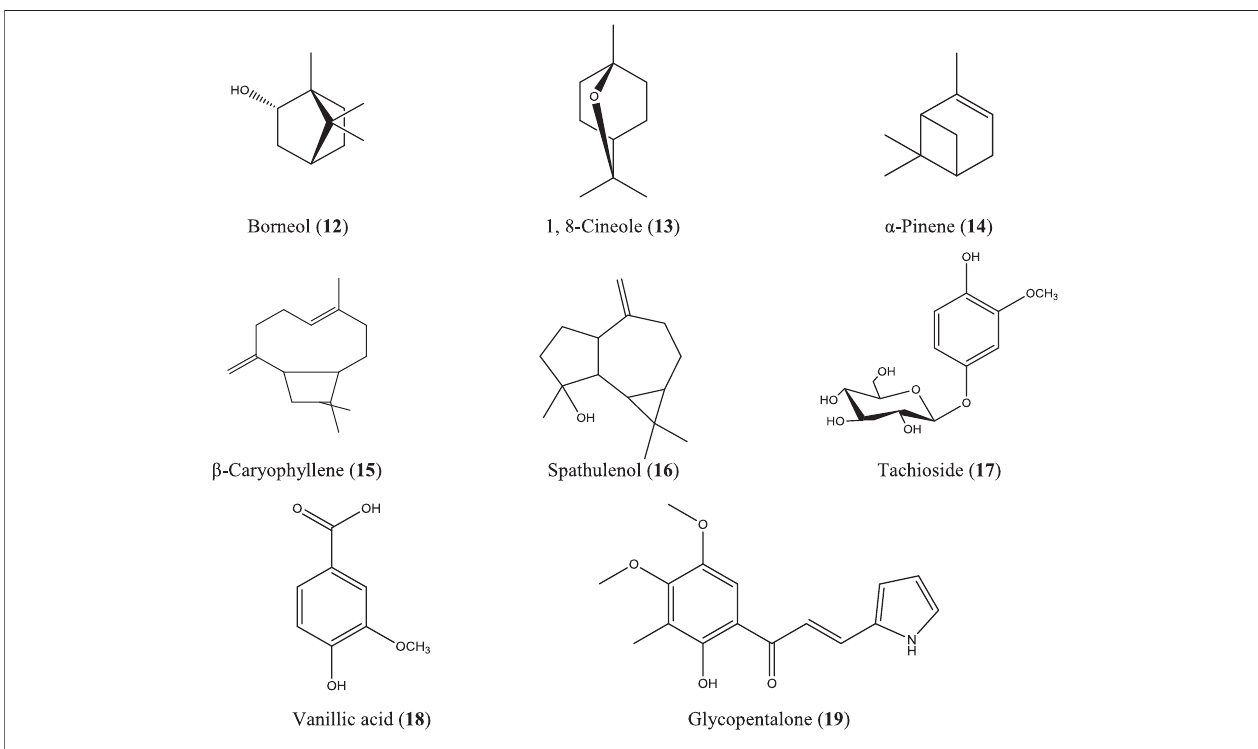
FIGURE 6 | Anti-in fl ammatory compounds isolated from G. pentaphylla